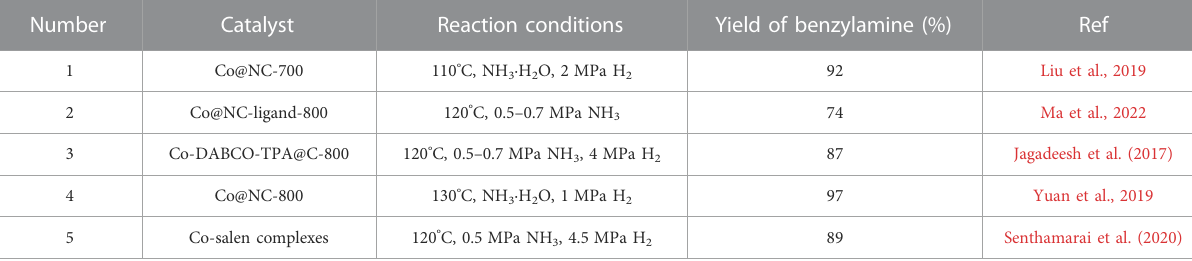
TABLE 1 Comparison on different Co-based catalysts in reductive amination. Number